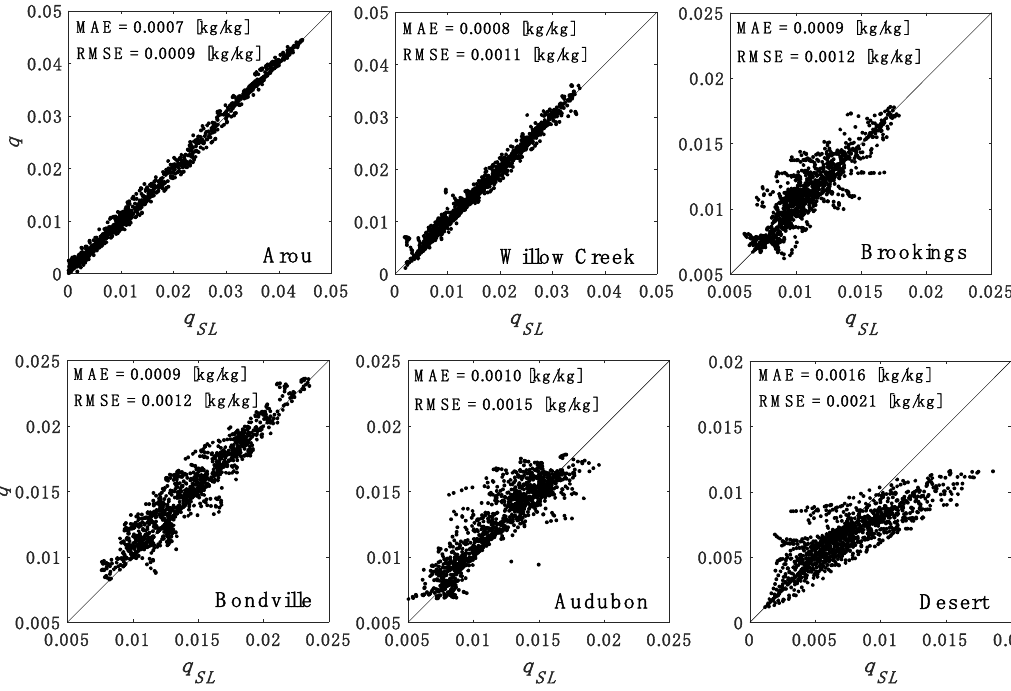
Figure 10. Scatterplot of half-hourly specific humidity ( q ) estimates versus q SL at the six experimental sites.